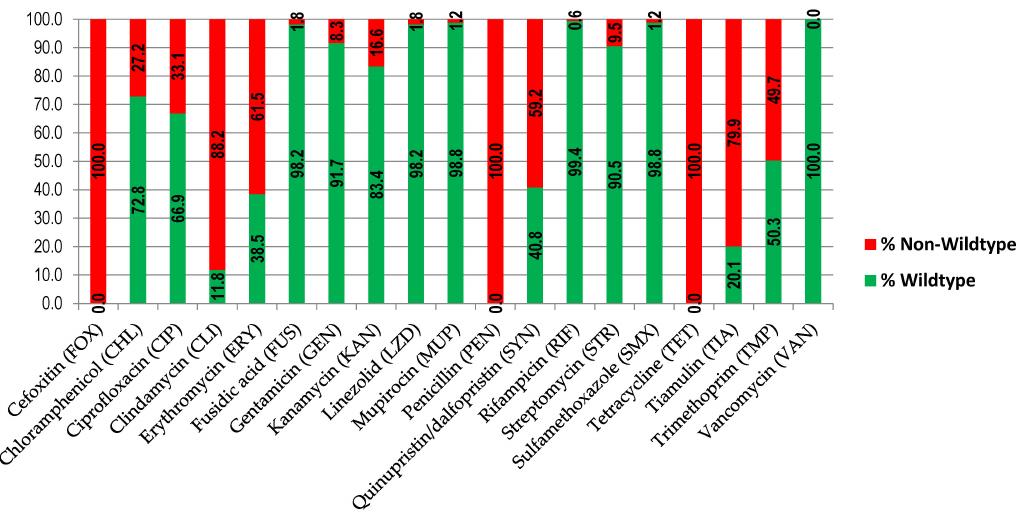
Figure 1. Antibiotic non-susceptibility resistance distribution of the MRSA isolates ( n = 169). Each bar represents the phenotypic result obtained for each antibiotic according to the ECOFF MIC values. The red bars represents the percentages of the non-wildtype isolates, and the green bars represents the percentages of the wild-type isolates for the respective